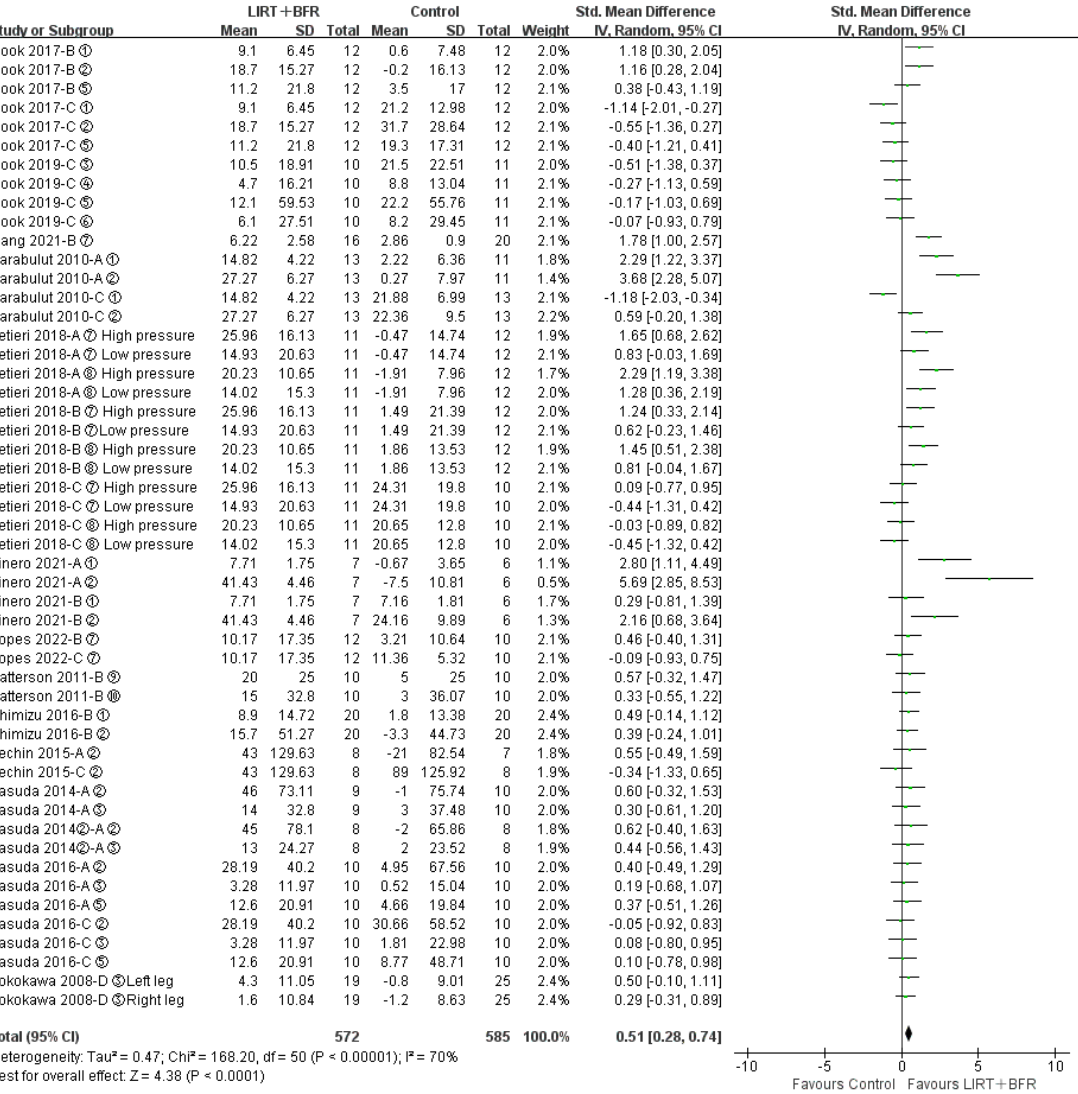
Figure 3. Meta-analysis of lower limb muscle strength [9,17 – 25,27 – 29]. Figure Notes: A, LIRT + BFR vs. daily exercise. B: LIRT + BFR vs. LIRT; C, LIRT + BFR vs. HIRT; D, LIRT + BFR vs. dynamic balance exercise. ① Leg extension-1RM (kg); ② Leg press-1RM (kg) ③ Knee extension-1/10RM (kg); ④ Knee flexion-1/10RM (kg); ⑤ knee extension-MVC (Nm); ⑥ Knee flexion-MVC (Nm); ⑦ Isokinetic knee extension (Nm); ⑧ Isokinetic knee flexion (Nm); ⑨ Dynamic plantar flexion-1RM (kg); ⑩ Dynamic plantar flexion-MVC (Nm).